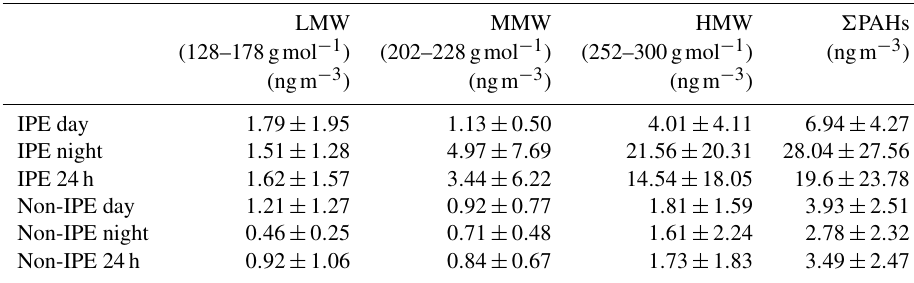
Table 1. Average values ± standard deviation of PAH concentrations categorized according to their molecular weight during wintertime intense pollution events